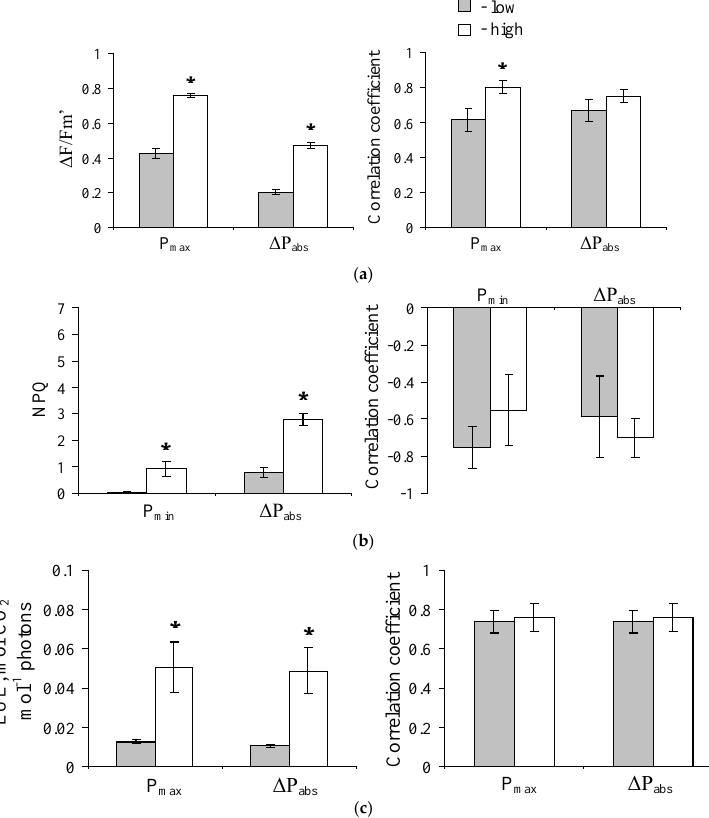
Figure 7. The influence of the distribution of ∆ F/F m ’ ( a ); NPQ ( b ) and LUE ( c ) on investigated plants for the connection between these photosynthetic parameters with PRI at measurements under artificial light. Average values of P min (P max ) and ∆ P abs are shown on left panels, average correlation coefficients are shown on right panels. The label “low” indicates groups with low P min (P max ) and ∆ P abs ; the label “high” indicates groups with high P min (P max ) and ∆ P abs . “Low” groups had n = 29 ( ∆ F/F m ’), n = 8 (NPQ), and n = 4 (LUE); “high” groups had n = 29 ( ∆ F/F m ’), n = 9 (NPQ), and n = 5 (LUE). * the group significantly differed from another one ( p < 0.05, Student’s